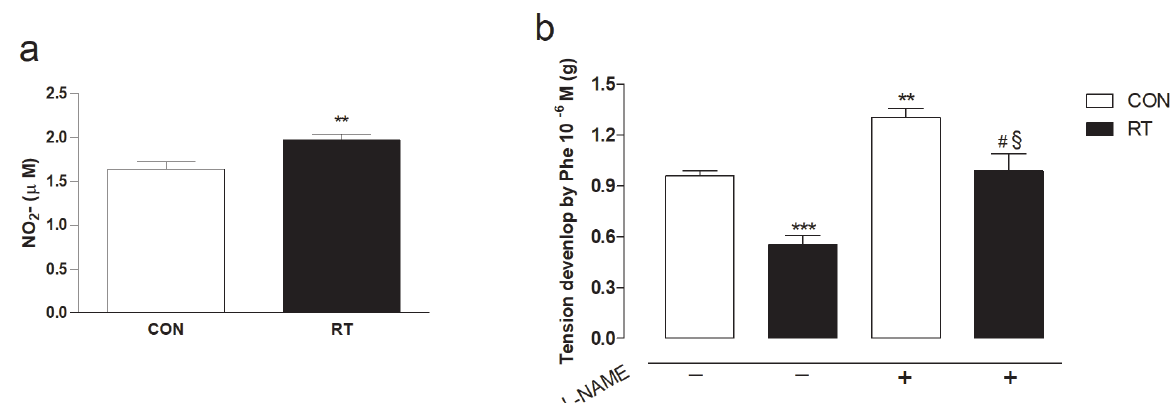
Figure 5. (a) Indirect NO production by measuring nitrite levels. (b) Tension developed by phenylephrine (Phe) (1 μM) evaluated in the mesenteric artery of rats in the Control (CON) group and resistance training (RT) in the absence or presence of L-NAME (100 μM). Values are expressed as mean ± S.E.M for 8-10 experiments in each group. (a): **p <0.01 CON vs. RT; (b): **p <0.01 vs CON; #p <0.01 vs DEX + RT without L-NAME (-); §p <0.05 vs. CON pre- incubated with L-NAME